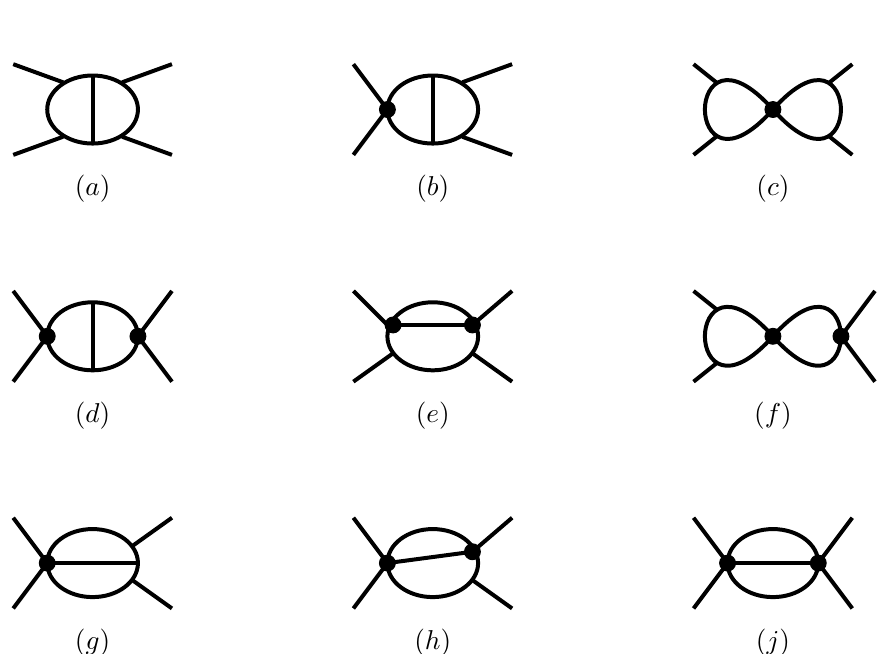
Figure 2 . ( a ) Two-loop ‘sunset’ diagram in supergravity (drawn sideways); ( b; c ) Two-loop di- agrams with one quartic vertex; ( d; e; f ) Two-loop diagrams with two quartic vertices; ( g; h; j ) Two-loop diagrams with quintic vertices; variants of these diagrams with non-planar topologies are also